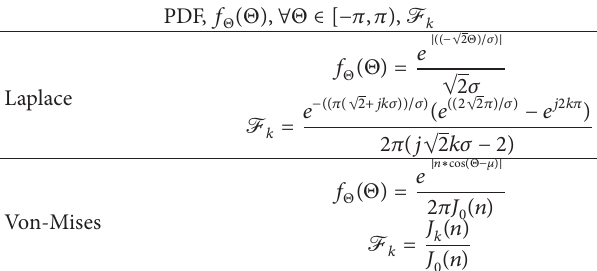
Table 2: Nonisotropic AAS and corresponding Fourier series